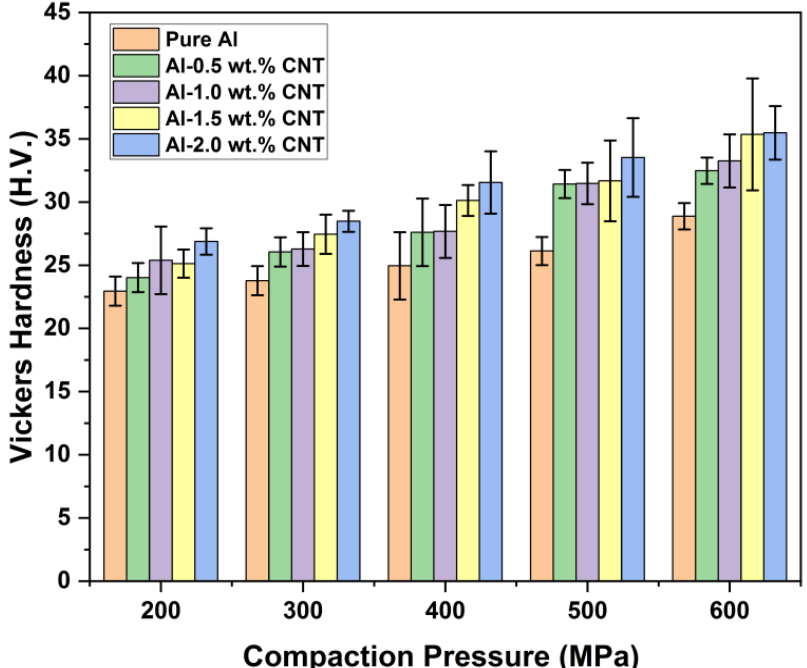
Figure 6. Effect of CNT content and compaction pressure on microhardness of sintered compacts. Table 2. Reported hardness and densities of Al-CNT-Sn composites fabricated by different processes.